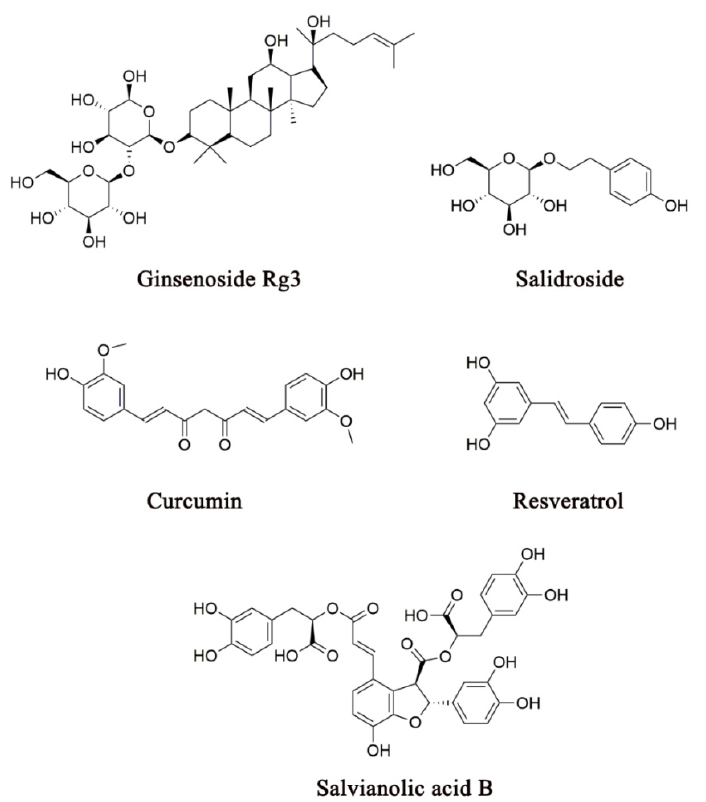
Figure 4. Several representative CHM constituents that have been shown to produce antidepressant effects through their actions on the neuroendocrine-immune network.